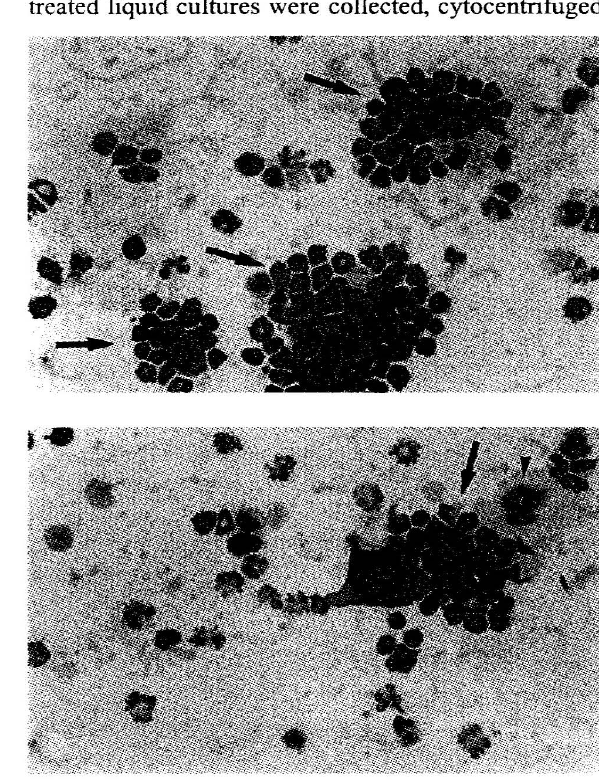
Figure 1. Cytospin preparations from the liquid mouse bone marrow culture, treated exogenously (24 h) with neopterin. One could see granulocyte/macrophageal colonies (arrows) with a single megacaryocyte (Mg-, arrow head) in one of them. Staining by the method of Zvetkova and Zvetkov; x 600 (14) PteridineslVol. 121N0. 4